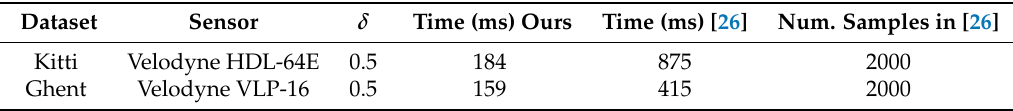
Table 2. Processing times for our registration algorithm and the one of [26] on the KITTI dataset as well as on our own dataset recorded in